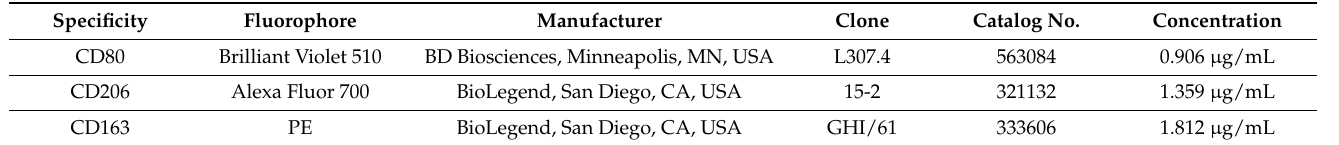
Table 2. Antibodies Used in Flow Cytometry